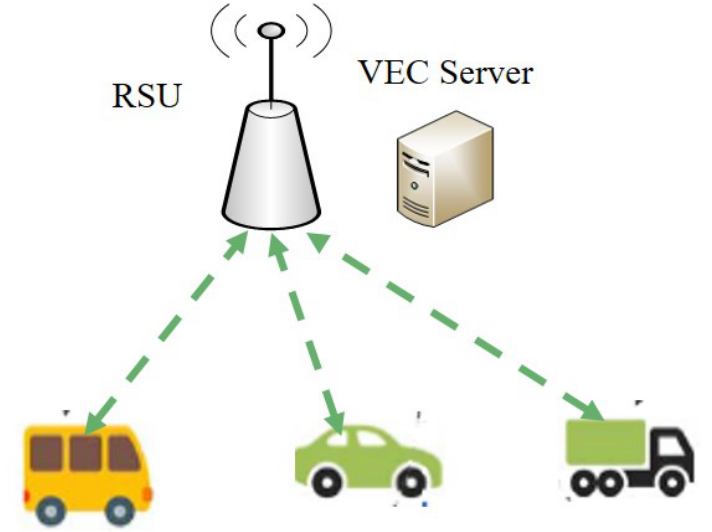
Figure 1. System